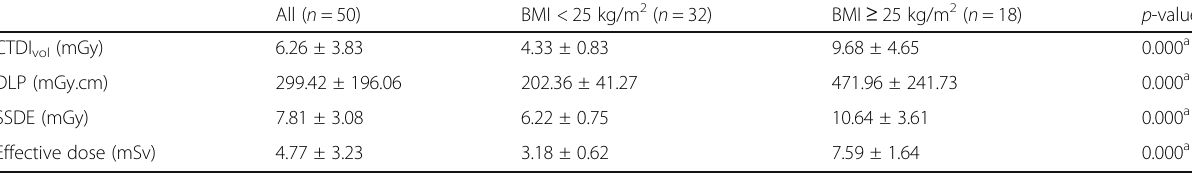
Table 1 Summary of mean values for computed tomography dose metrics, overall and stratified for body mass index (BMI) All ( n = 50)